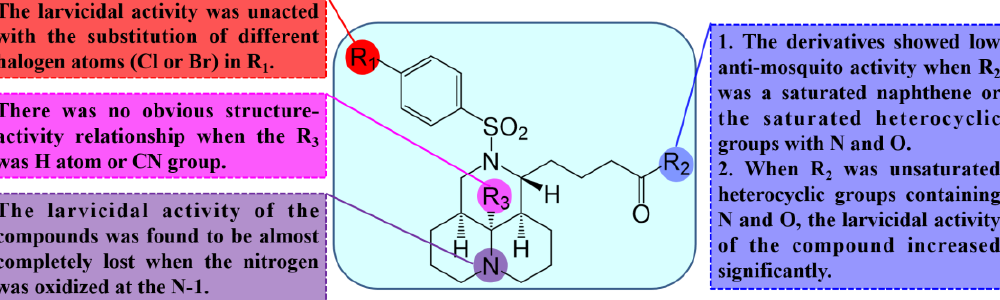
Figure 4. The Structure-activity relationships of MA derivatives.